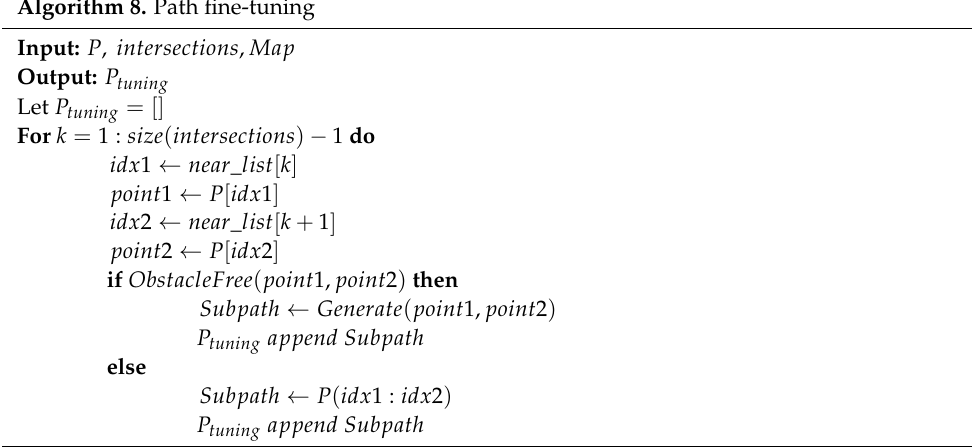
Algorithm 8. Path